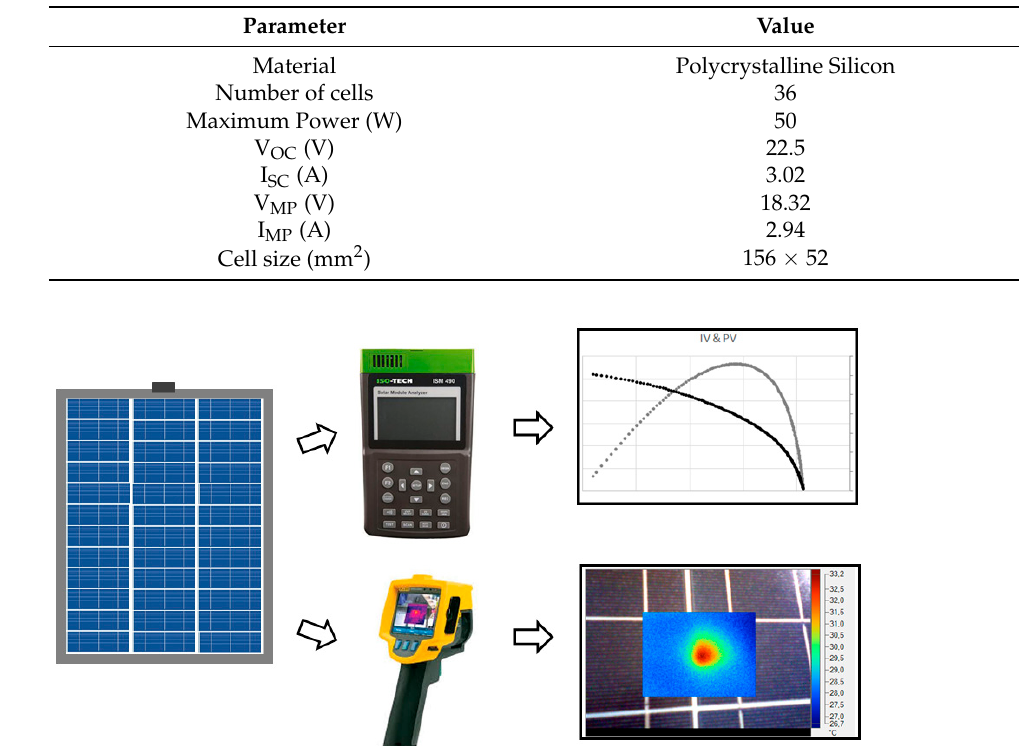
Table 1. Characteristics of the PV panel.